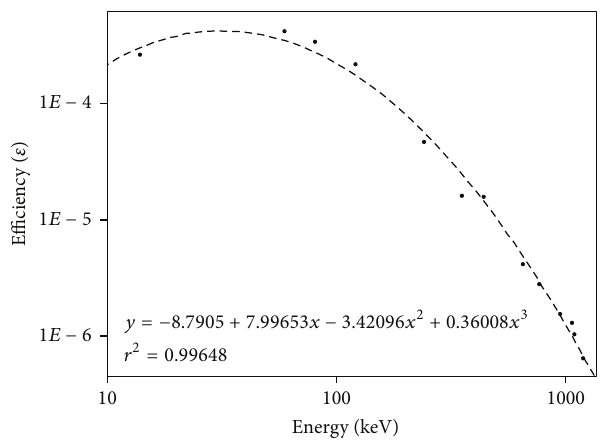
Figure 5: The photopeak efficiency curve for HPGe detector.